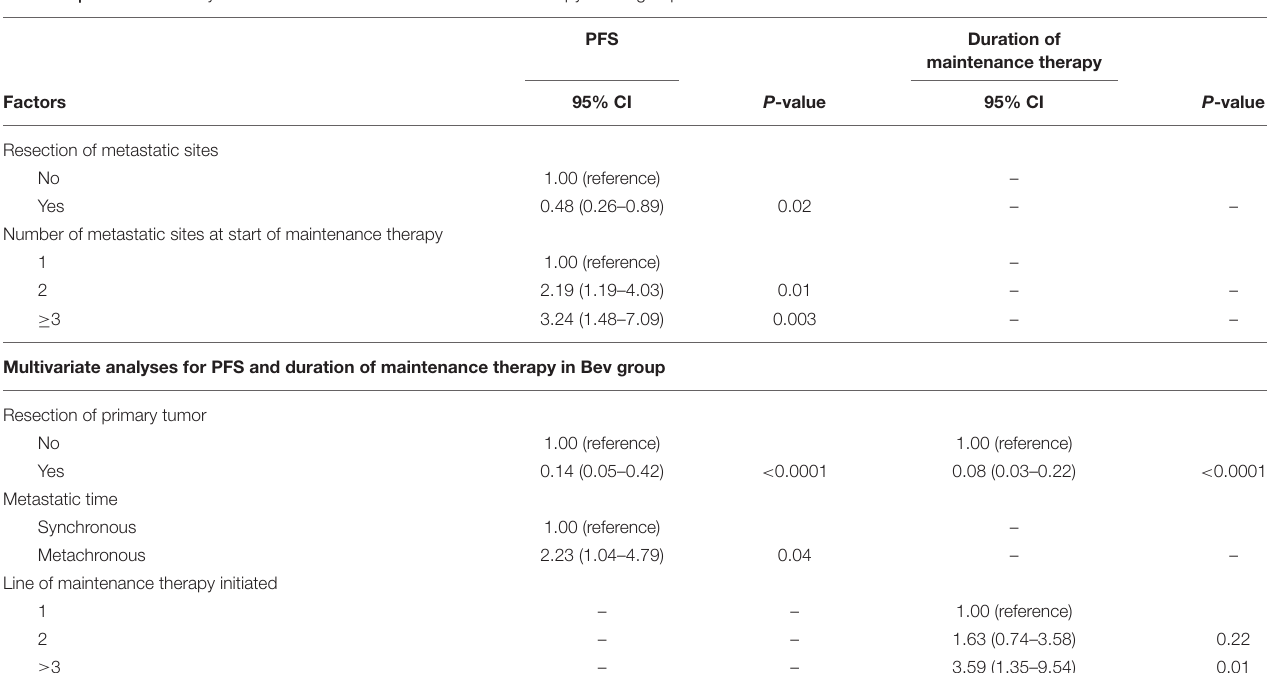
TABLE 4 | Multivariate analyses for PFS and duration of maintenance therapy in Cet